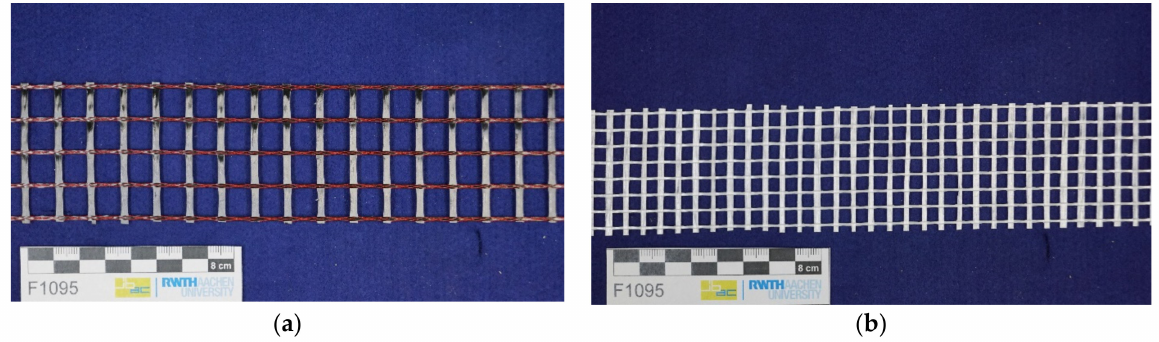
Figure 1. ( a ) Reinforcement for the extrusion process: pre-cut carbon textile ( b ) pre-cut glass